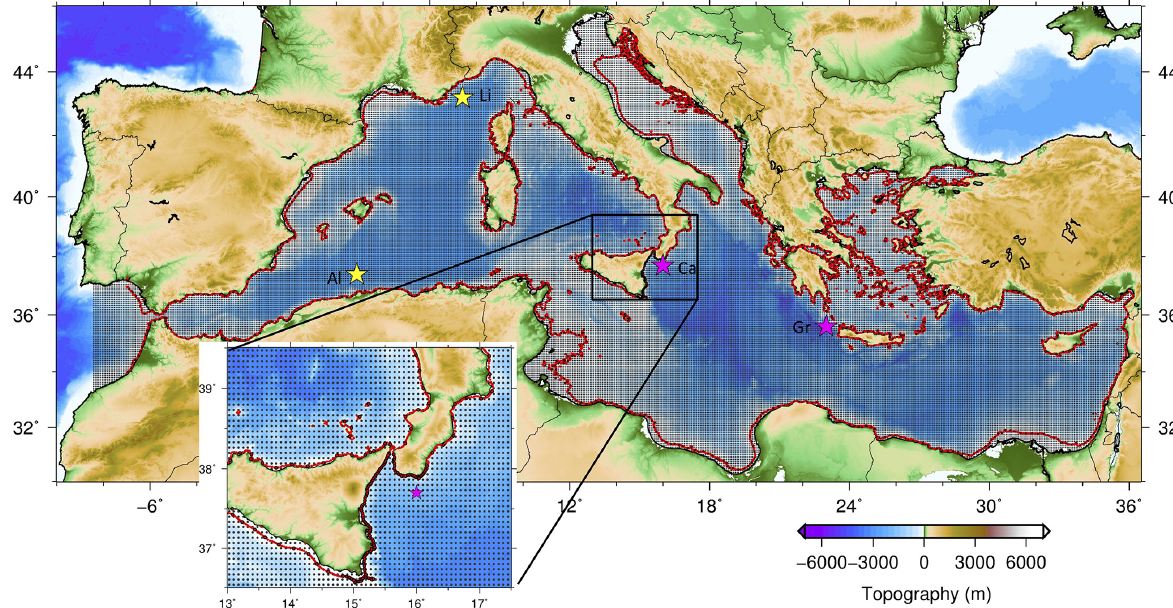
Figure 1. Spatial distribution of the Gaussian-shaped elementary sources (black dots) covering the Mediterranean Sea and position of tsunami receivers on the 50m isobaths (red dots) where the pre-computed tsunami waveforms are evaluated. Yellow (maximum considered magnitude up to 8.0) and magenta (maximum considered magnitude up to 8.5) stars mark the epicentres used in our performance analysis presented in Sect. 3 (Al is Algeria, Li is Liguria, Ca is Calabria and Gr is